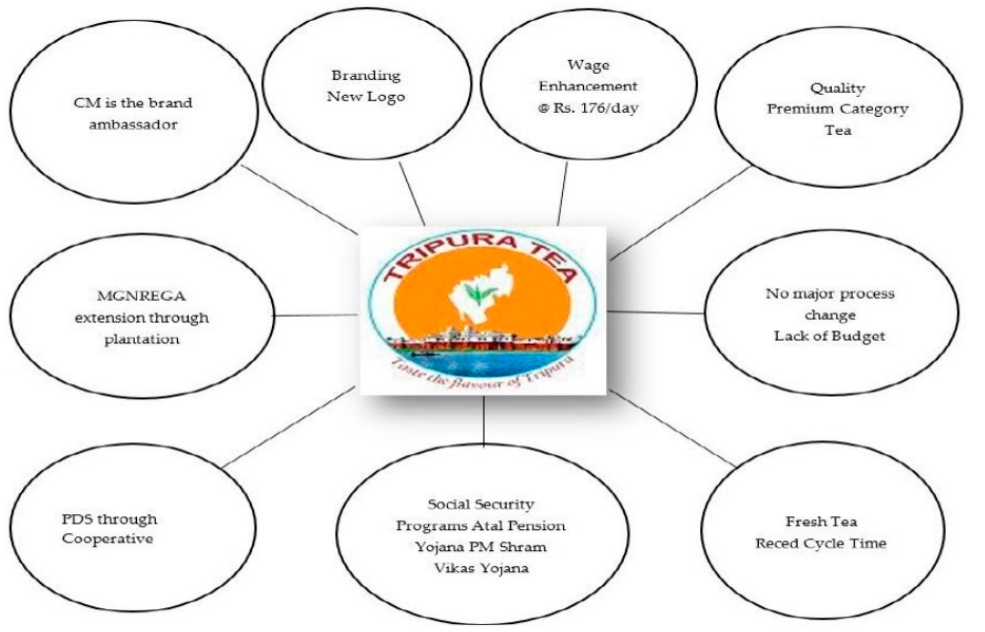
Figure 8. The strategies undertaken by TTDC for growth of tea industry.